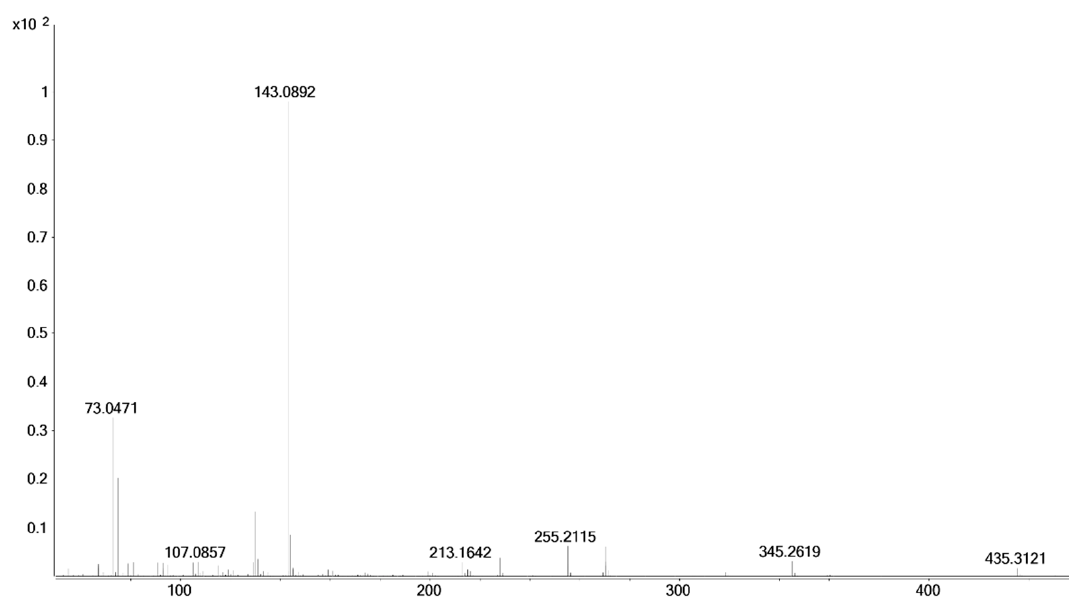
Figure 7. Mass spectrum (GC-EI-QTOF-MS, 70 eV) of 17 β -methyl-5 β -androstane-3 α ,17 α -diol ( 11 ), bis TMS (x-axis: m / z ; y-axis: relative abundance).